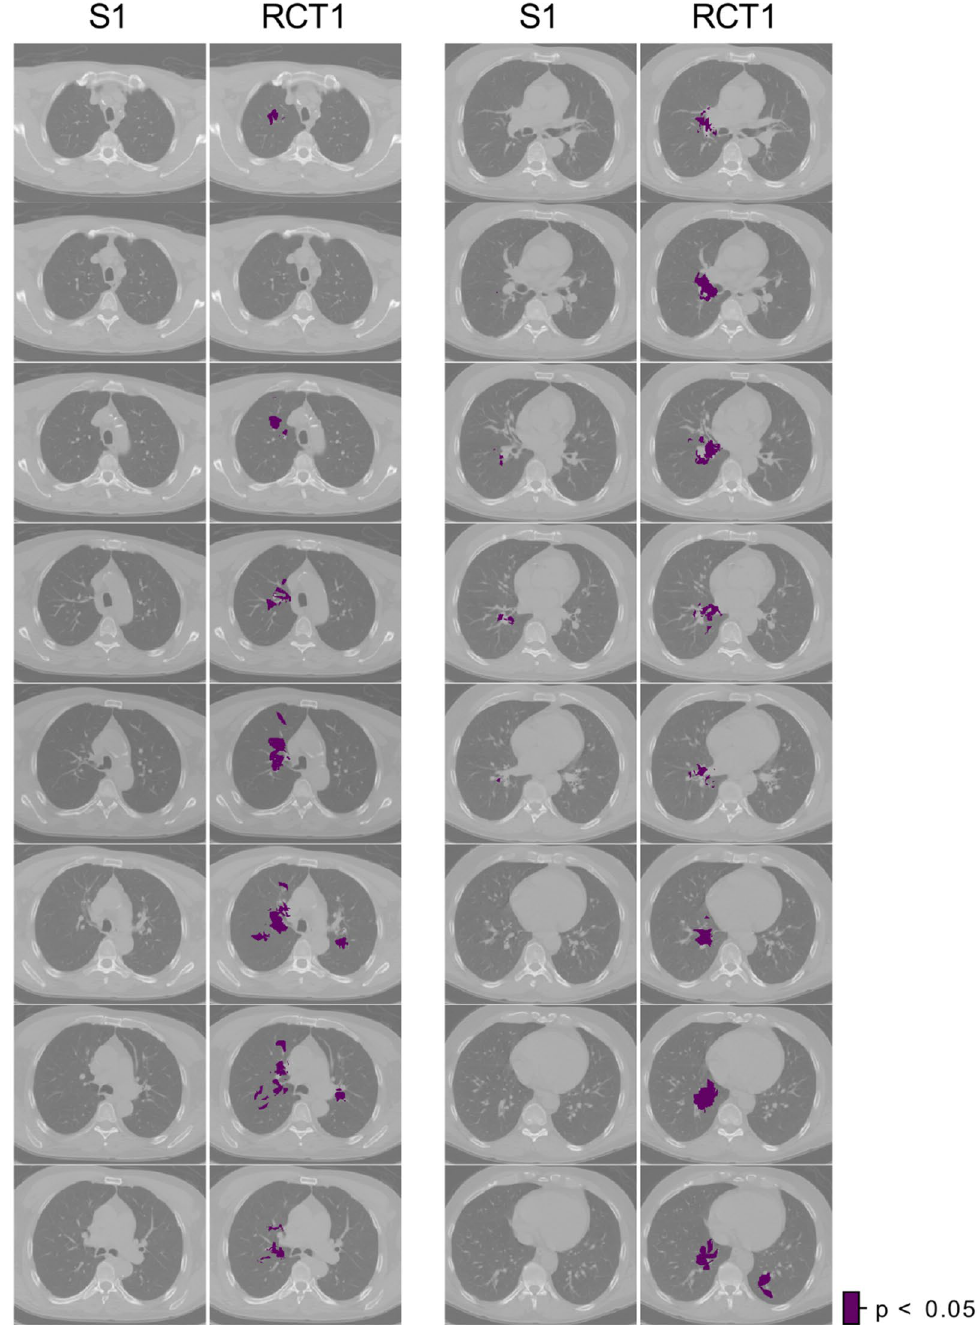
Figure 4. Comparison of decreased survival areas (DSA, violet) between S1 and RCT1 cohorts. Axial slices are shown with 3 slice step intervals (9.81 mm). S1 cohort shows an isolated location on the right lung side, whereas the DSA are spread in superior and inferior direction for